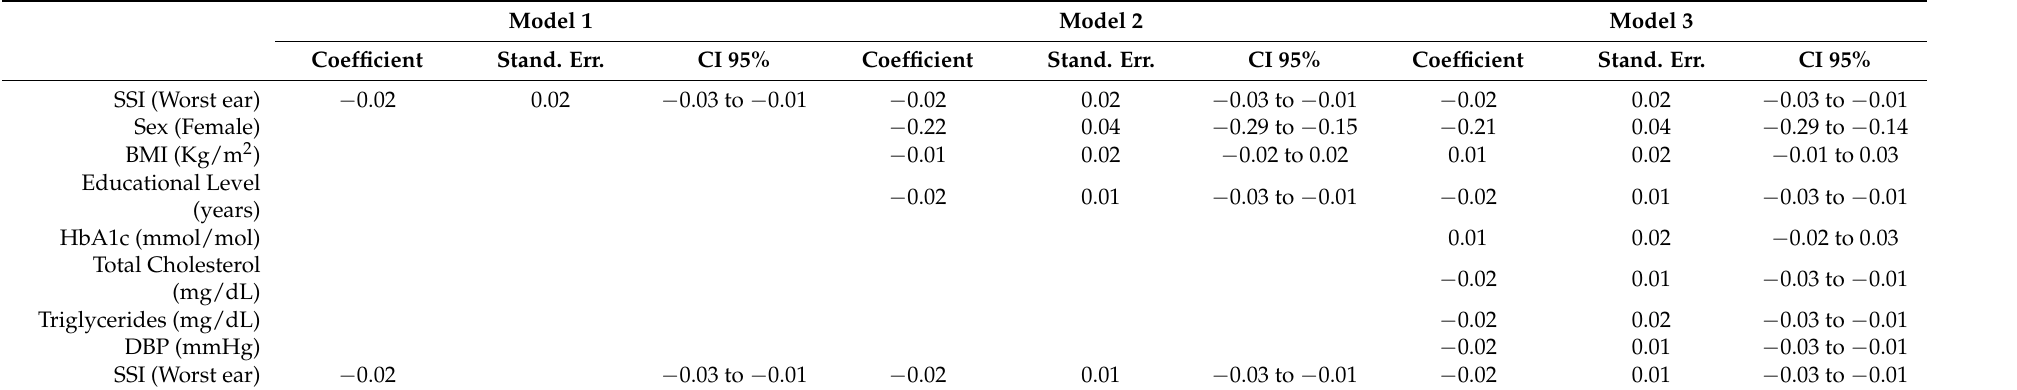
Table 3. Multiple rank-based regression models of FIB-4 score as dependent